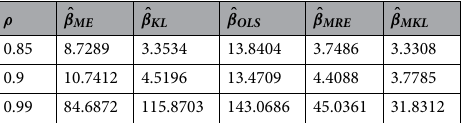
Table 10. Estimated MSE when σ